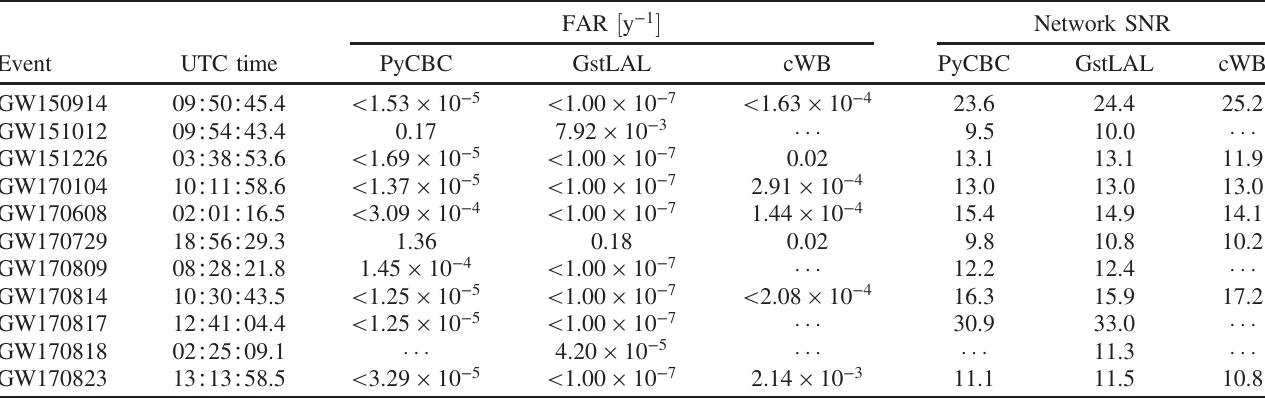
TABLE I. Search results for the 11 GW events. We report a false-alarm rate for each search that found a given event; otherwise, we display (cid:2) (cid:2) (cid:2) . The network SNR for the two matched-filter searches is that of the template ranked highest by that search, which is not necessarily the template with the highest SNR. Moreover, the network SNR is the quadrature sum of the detectors coincident in the highest-ranked trigger; in some cases, only two detectors contribute, even if all three are operating nominally at the time of that event. FAR ½ y − 1 (cid:3)